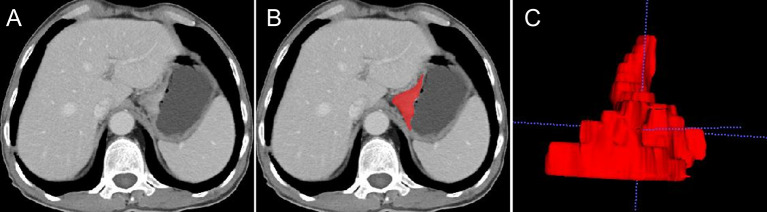
An example of manual segmentation of EGJ adenocarcinoma. (A) A localized mass with heterogeneous enhancement is observed at the EGJ on the venous-phase CT image. (B) Segmentation of the same axial slice. (C) 3D volumetric reconstructions of the tumor generated from ITK-SNAP.